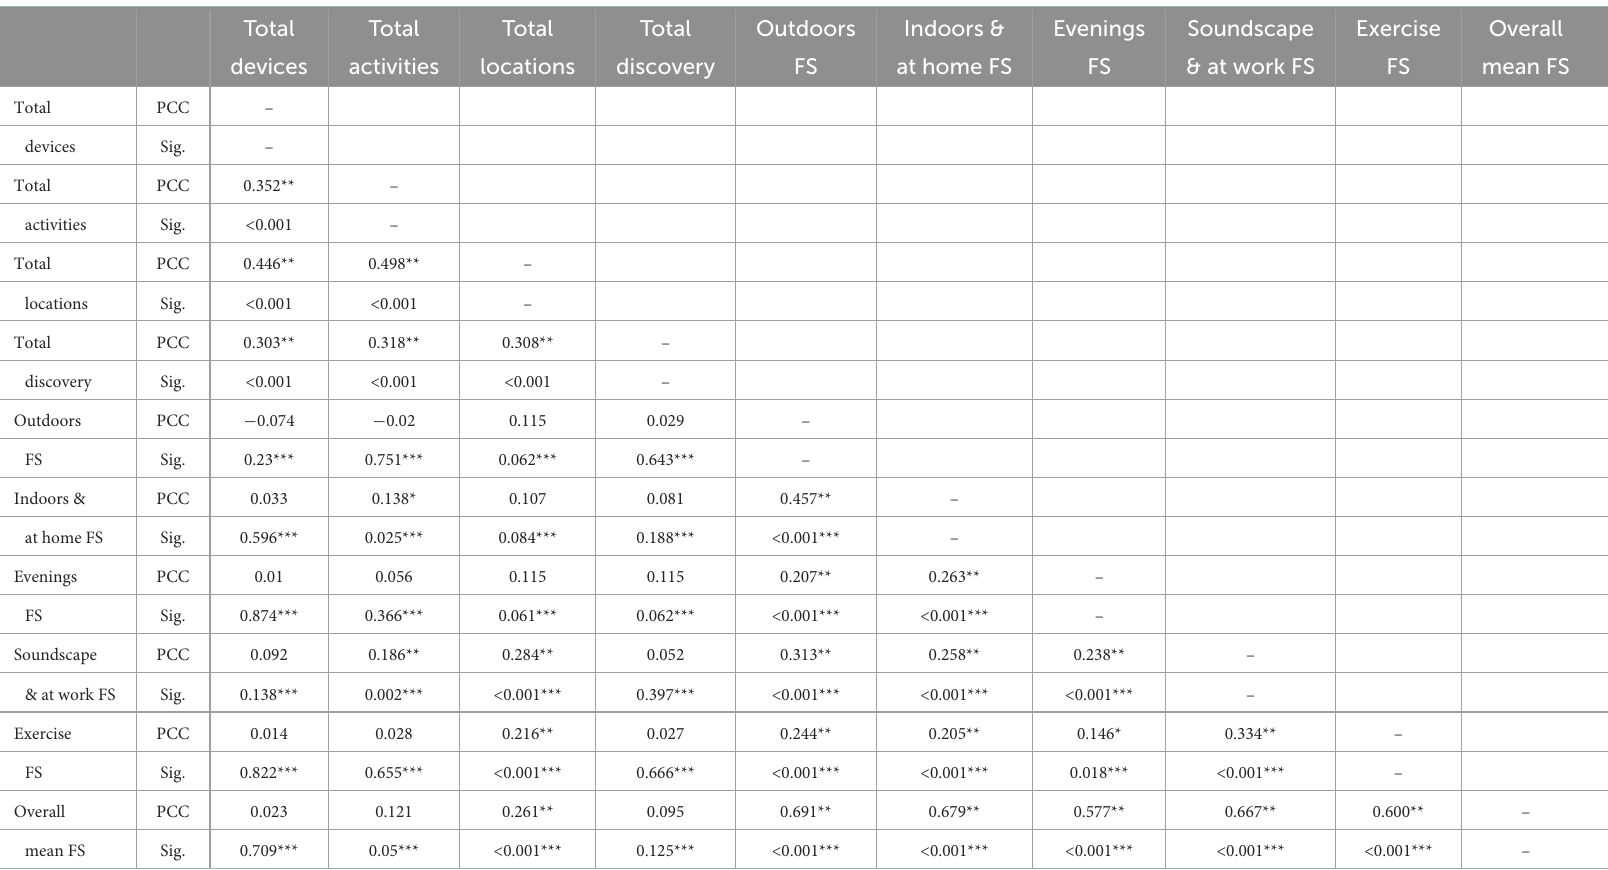
*Correlationissignificantatthe0.05level(2-tailed).**Correlationissignificantatthe0.01level(2-tailed).***FS =